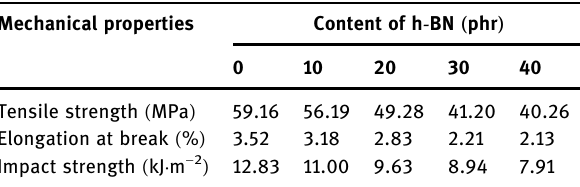
Table 1: Mechanical properties of EP/h - BN composites